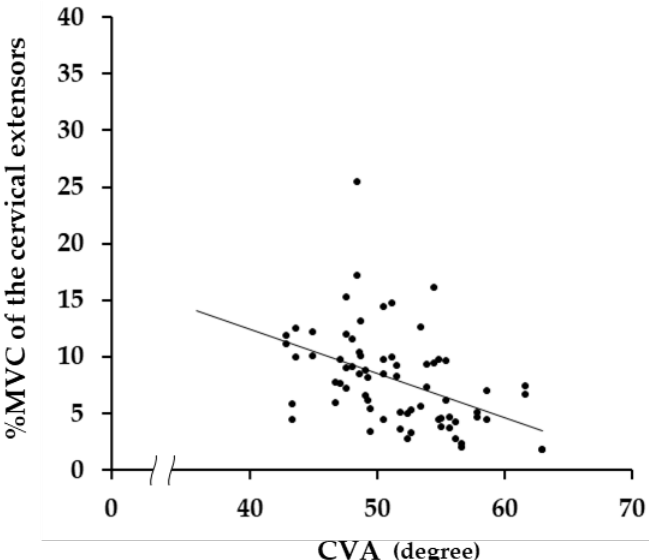
Figure 3. The correlations between craniovertebral angles (CVAs) and %MVCs in Phase II of the cervical extensors in the neutral position. There was a significant negative correlation between them (r = −0.4 51, p < 0.001).